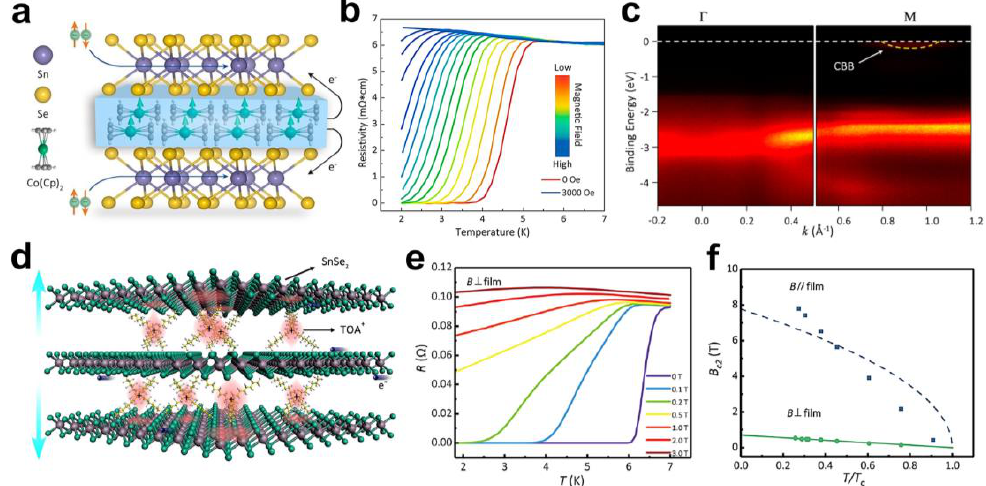
Figure 2. ( a ) Schematic diagram of a 2D organic − inorganic SnSe 2 -Co(Cp) 2 superlattice structure. Reproduced with permission from Ref. [30]. Copyright 2017, American Chemical Society (Washington, DC, USA). ( b ) Temperature dependence of the resistivity of 2D SnSe 2 -Co(Cp) 2 superlattices at different magnetic fields. Reproduced with permission from Ref. [30]. Copyright 2017, American Chemical Society. ( c ) The SnSe 2 -Co(Cp) 2 superlattice energy band structure shown by ARPES. Reproduced with permission from Ref. [30]. Copyright 2017, American Chemical Society. ( d ) Schematic diagram of the crystal structure of (TOA) x SnSe 2 . Reproduced with permission from Ref. [31]. Copyright 2021, American Chemical Society. ( e ) Temperature dependence of the resistance in an out-of-plane magnetic field. Reproduced with permission from Ref. [31]. Copyright 2021, American Chemical Society. ( f ) Temperature dependence of in-plane critical magnetic field and out-of-plane critical magnetic field. Reproduced with permission from Ref. [31]. Copyright 2021, American Chemical Society.